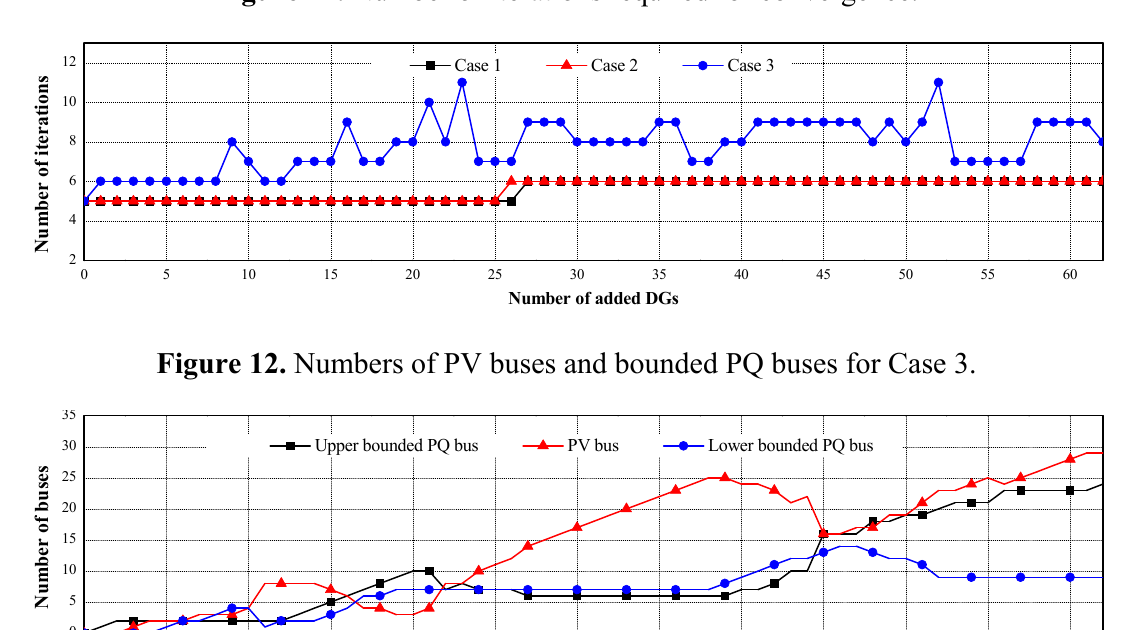
Figure 11. Number of iterations required for convergence.